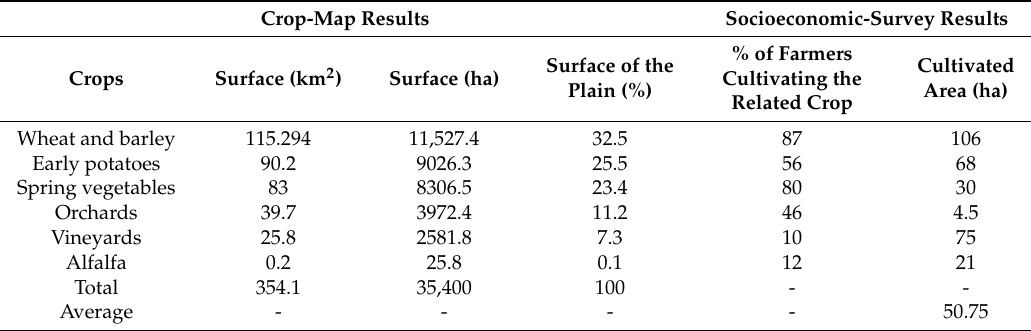
Table 2. Crop-type surfaces in the Bekaa Valley in 2017.